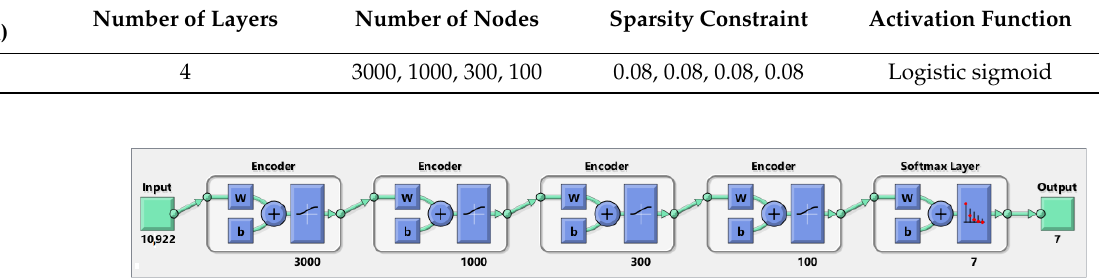
Table 4. The optimal selected parameters for constructing the SSA-DNN model.